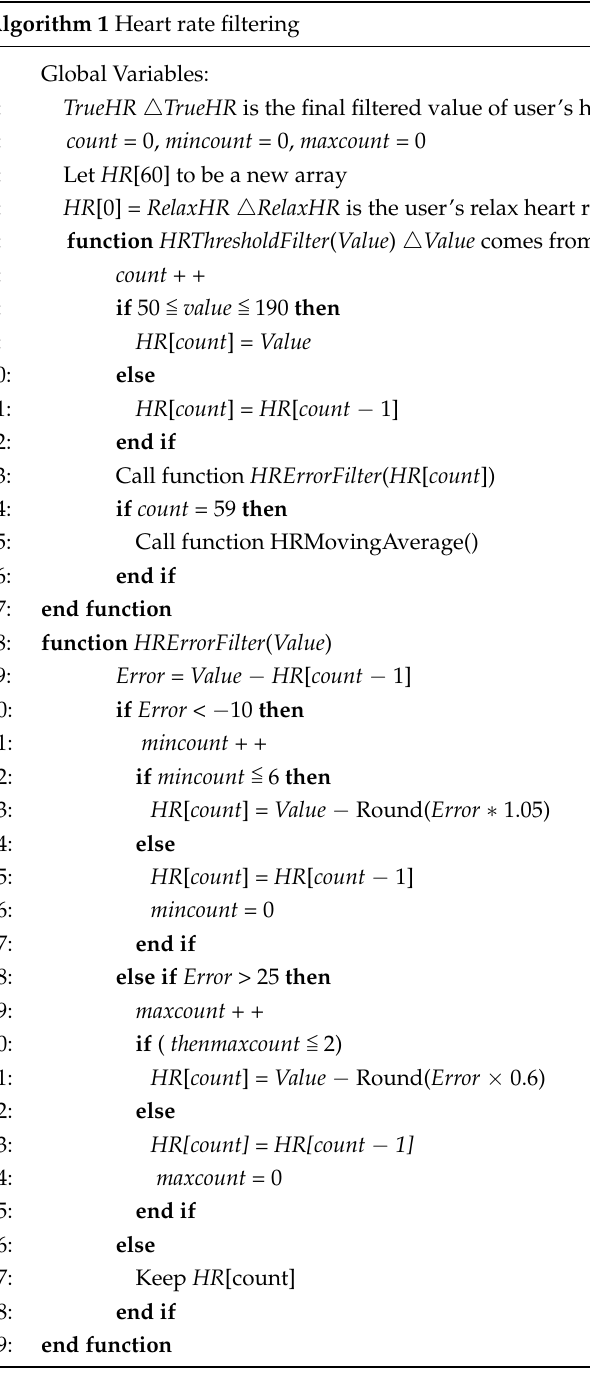
Algorithm 1 Heart rate filtering